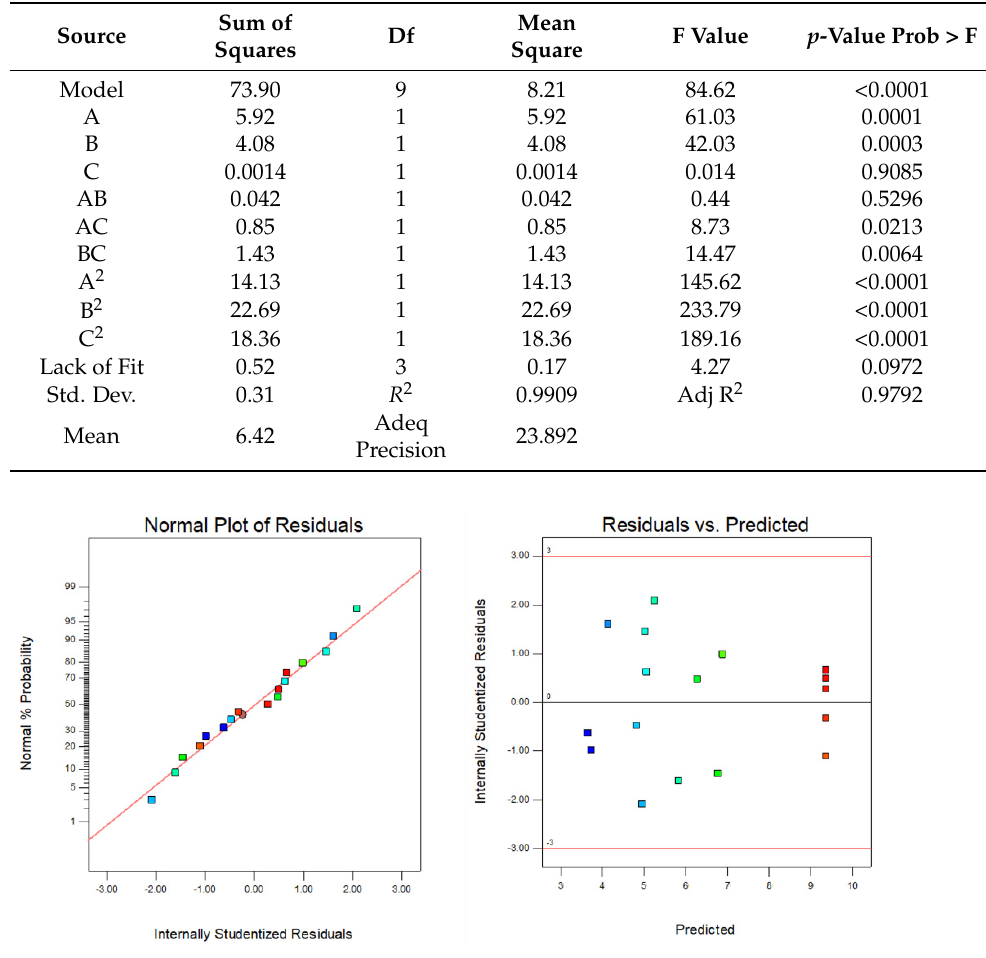
Figure 1. Normal distribution validation and residuals versus predictions.